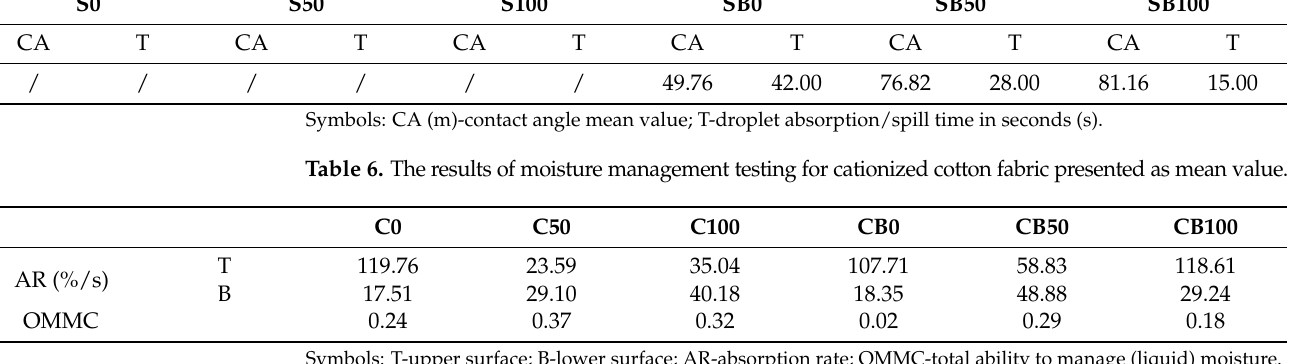
Table 5. Drop shape analyser (DSA) results for standard (non-cationized) cotton fabric. S0 S50